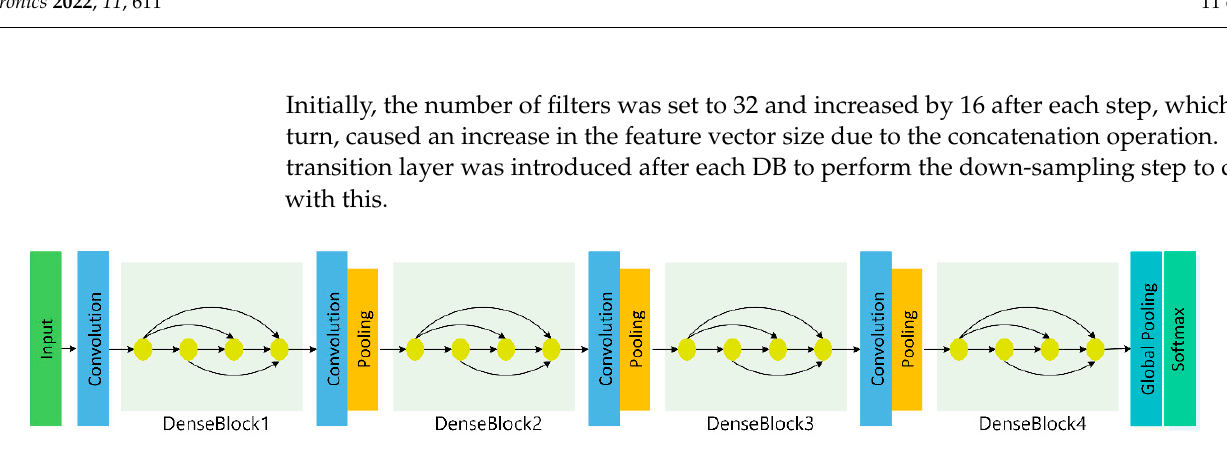
Figure 2. Architecture of the 1D DenseNet framework.